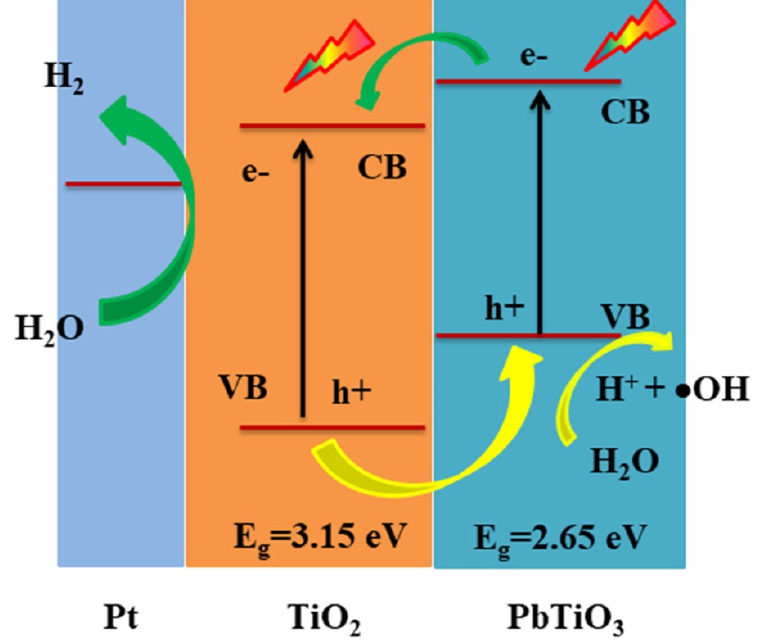
Figure 6. Proposed mechanism for the photocatalytic H 2 evolution in water splitting over octahedral shaped PbTiO 3 -TiO 2 nanocomposites.